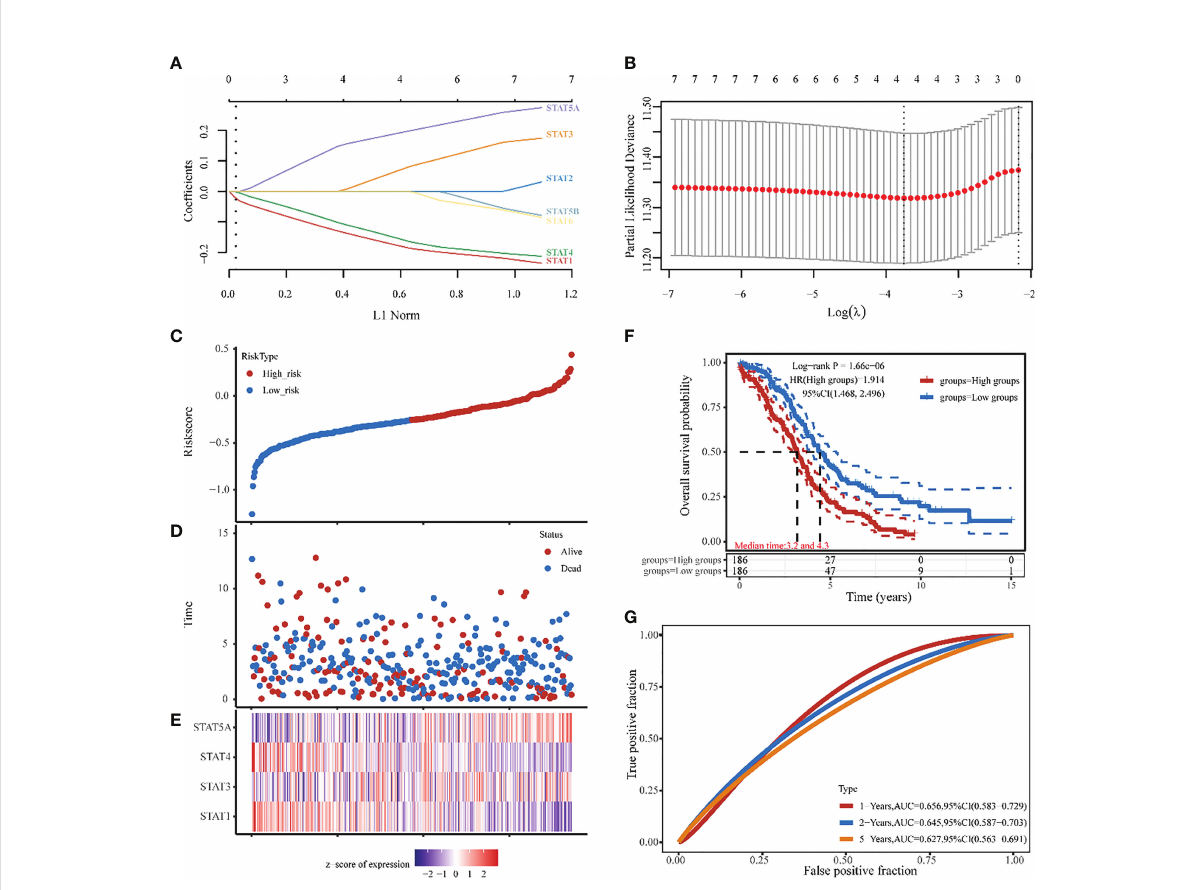
FIGURE 6 Ovarian cancer survival prediction and STAT genes selection. (A) The coef fi cients of 7 STATs in the LASSO model were screened by 10-fold cross-validation. (B) Analysis of the seven selected STATs by X-tile. (C, D) The selected dataset ’ s risk score, survival time, and survival status. (E) The heatmap was the gene expression from the signature. (F) A risk model for signature OV patients with Kaplan-Meier survival analysis. HR (High exp) represents the hazard ratio of the low-expression sample relatives to the high-expression sample. (G) ROC curves of 1,2,5 years, 1-, 2-, and 5-year overall survival probability based on the STATs Risk score.